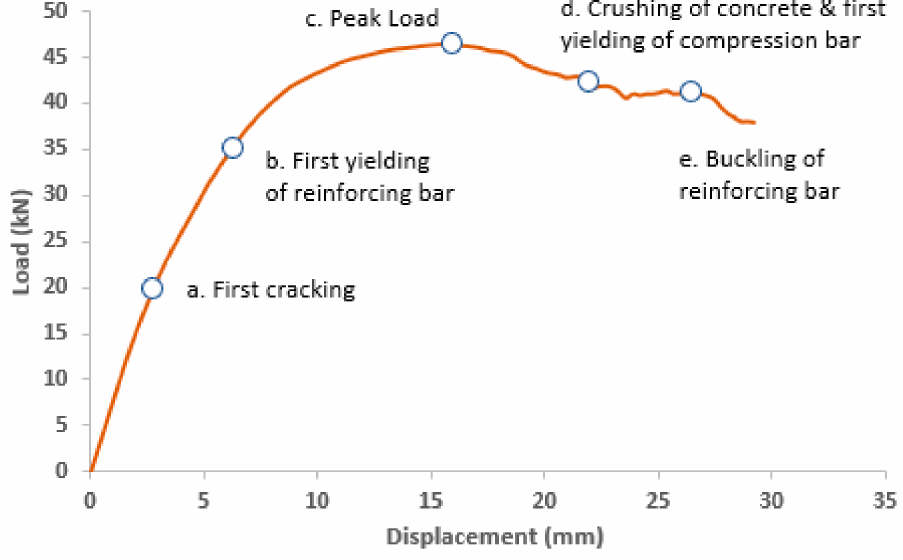
Figure 6. Points of progressive